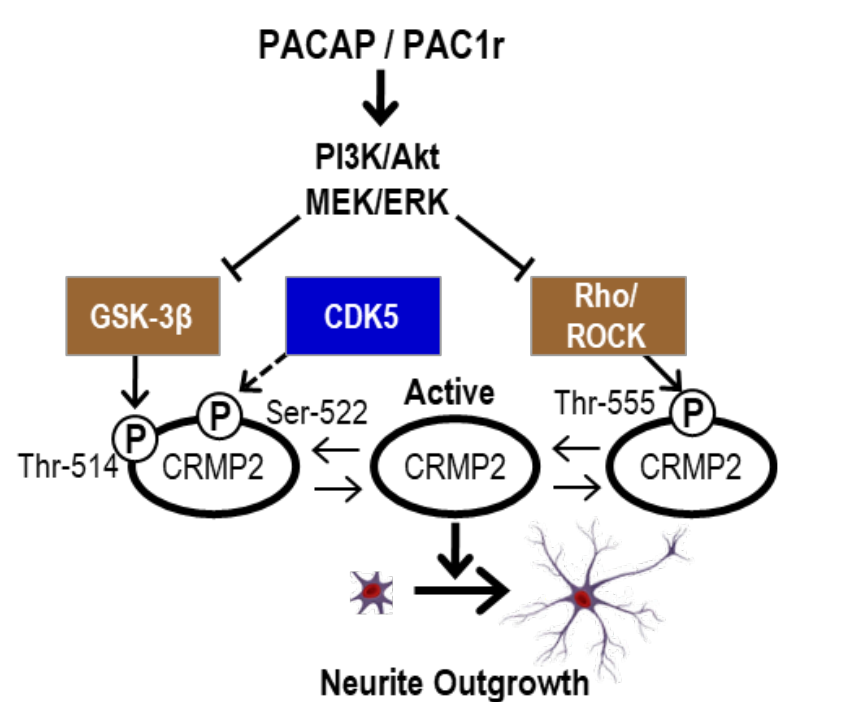
Figure 1. Scheme of Pac1r-mediated projection elongation of PACAP. The projection elongation action of PACAP depends on the dephosphorylation of CRMP2 through the regulation of Gsk3b, CDK5, and Rho/ROCK, with Pac1 receptor-mediated PI3K/AKT and MEK/ERK as the main pathways. The dephosphorylated CRMP2 becomes active and promotes projection elongation.